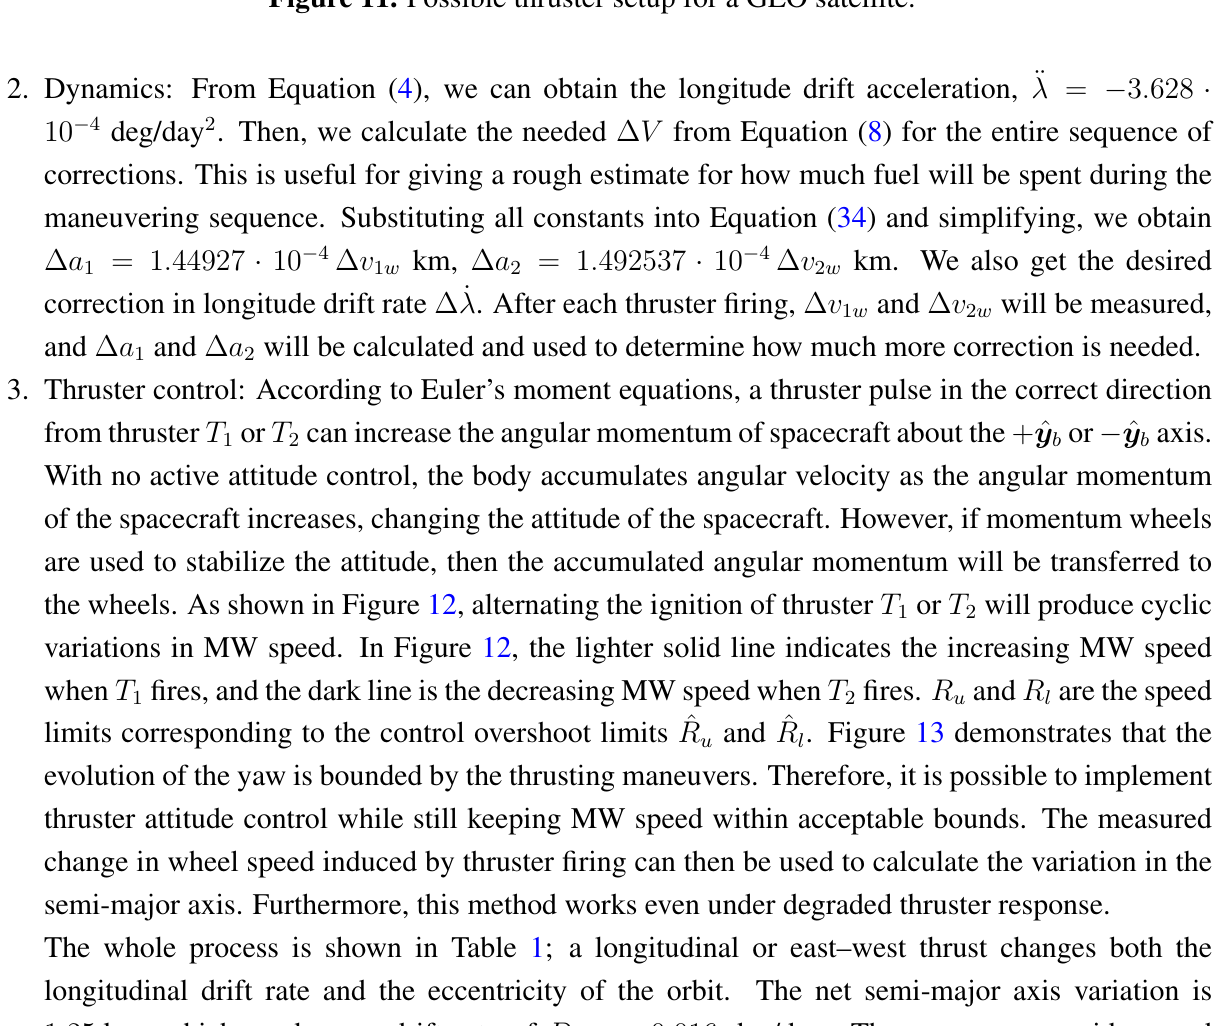
Figure 11. Possible thruster setup for a GEO